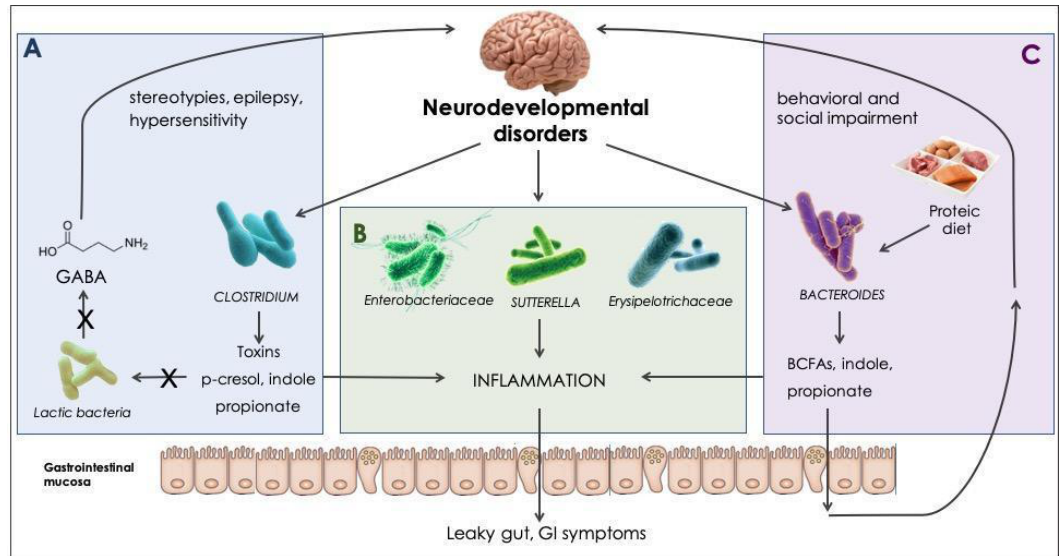
Figure 2. Microbial modulation in neurodevelopmental disorders. Effects driven directly or indirectly by gut microbes, found to be increased in NDs and their products. ( A ) Clostridia are spore-forming, toxigenic bacteria, with proteolytic ability [53]; digestion of aromatic amino acids results in phenol, p-cresol, and indole production. High indole concentrations can suppress bifidobacteria and lactobacilli growth [77]. Lactic bacteria are known to endogenously produce